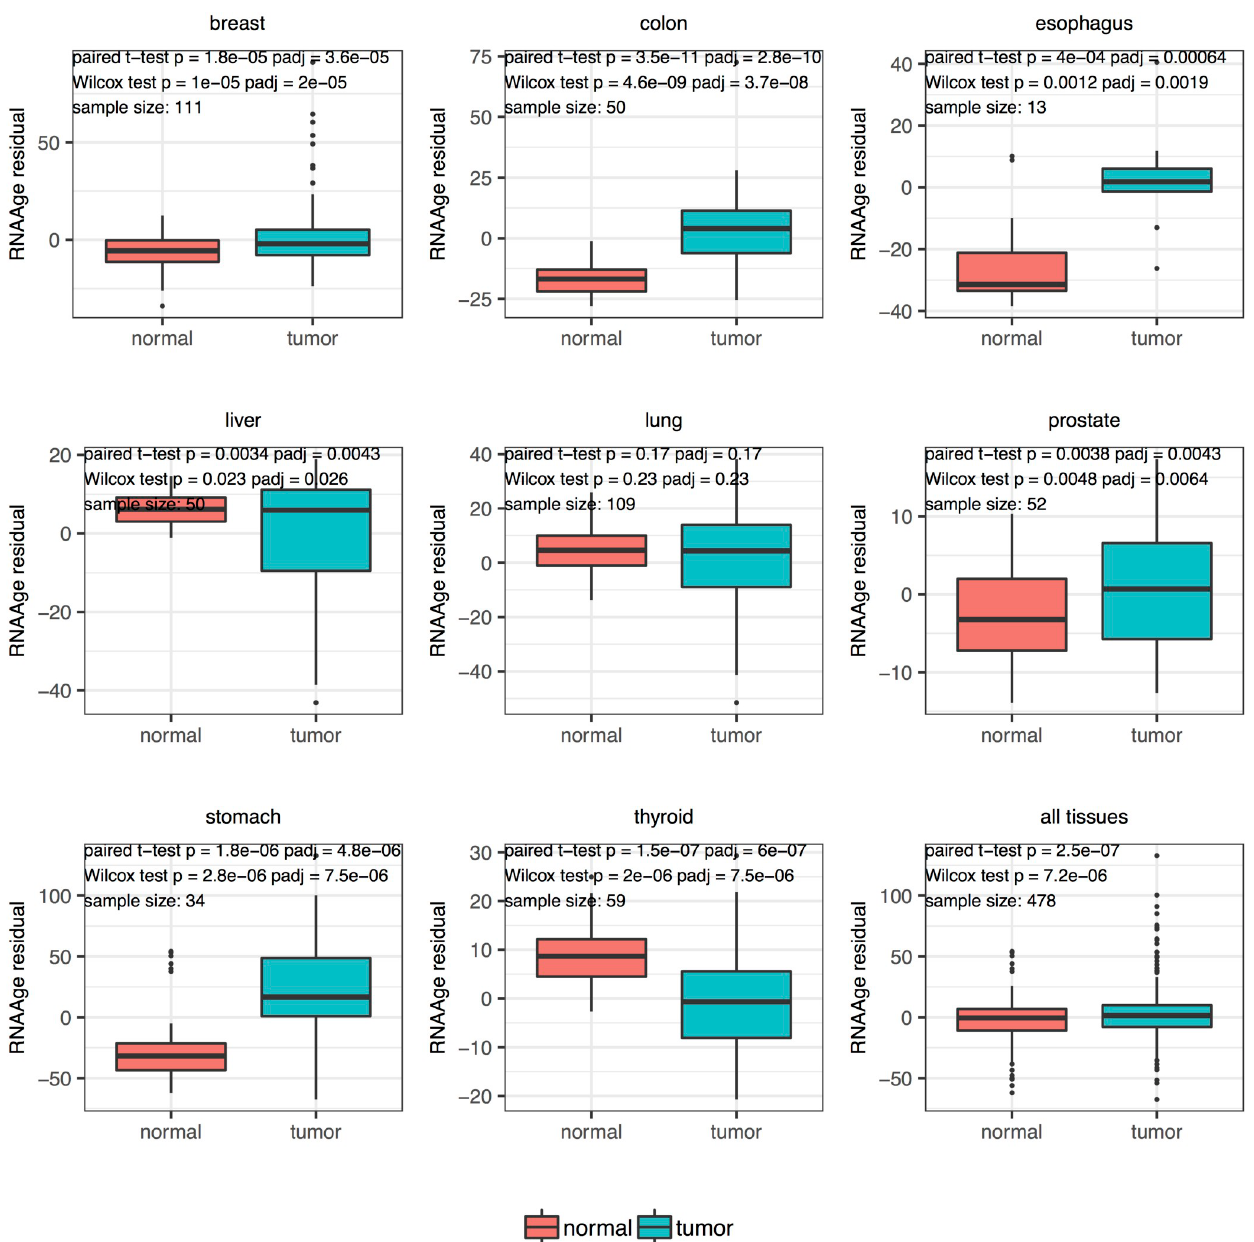
Fig 3. Age predictions on matched tumor and normal samples from